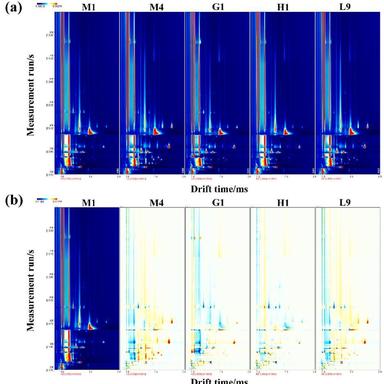
GC-IMS spectral analysis of baijiu brewed from different raw materials. (a) 2D top view; (b) difference spectra.